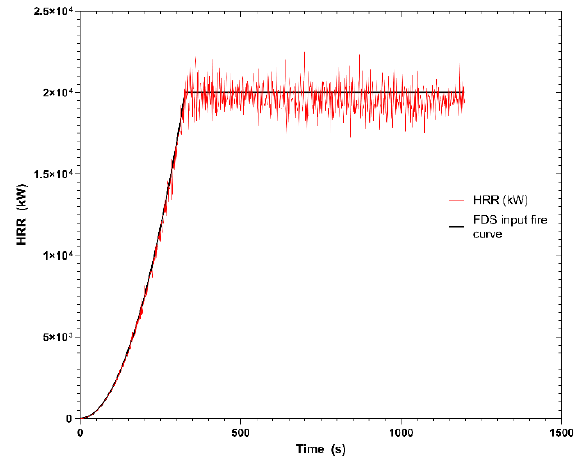
Figure 6. FDS input fire curve and FDS results fire curve.